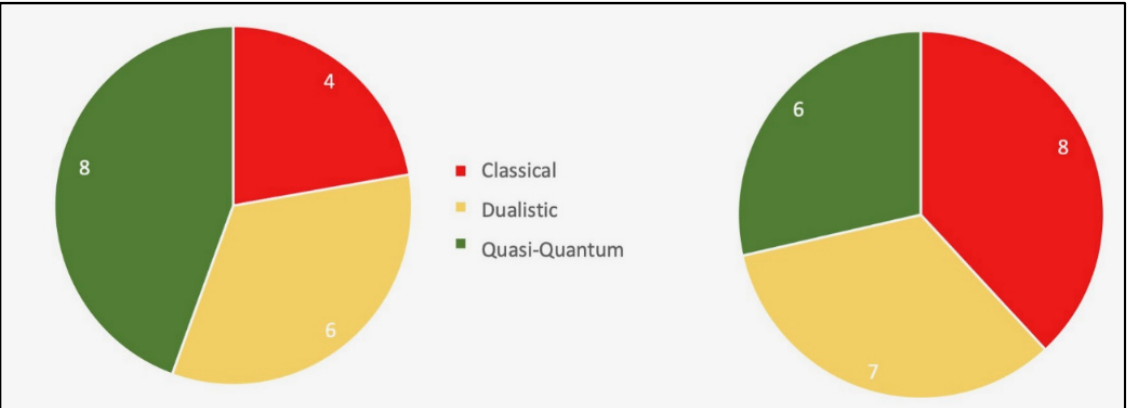
Figure 6. Particle arguments in detail ( left ) before the students were engaged with the experiment and ( right ): after the students were engaged with the experiment. The absolute numbers of the students are indicated.